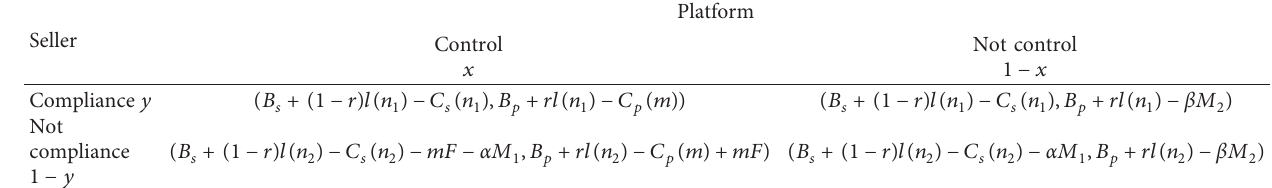
Table 2: The payoff matrix without risk